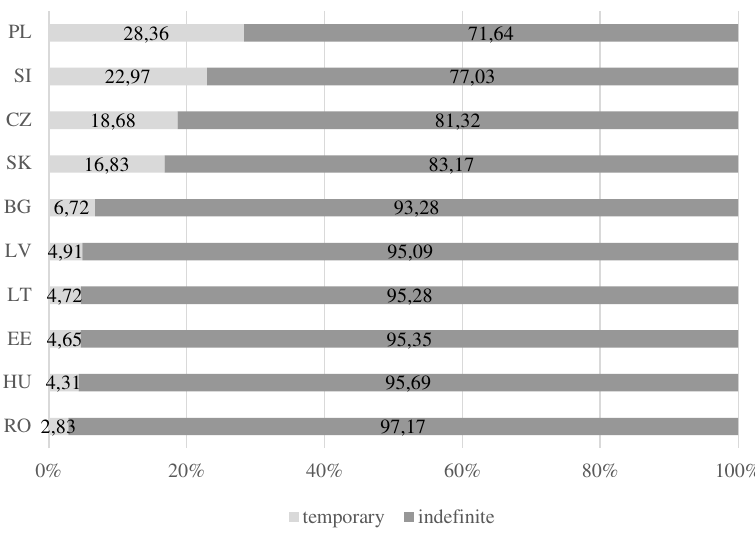
Figure 1. Share of temporary and indefinite contracts, by country, 2014